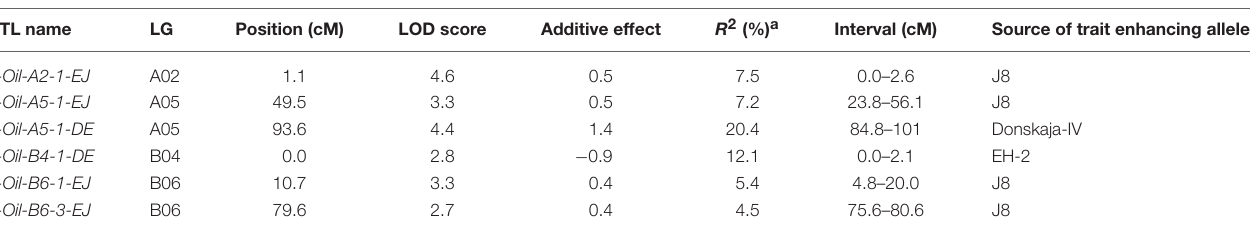
TABLE 6 | Details of the “novel” oil QTL identified in the three ZE